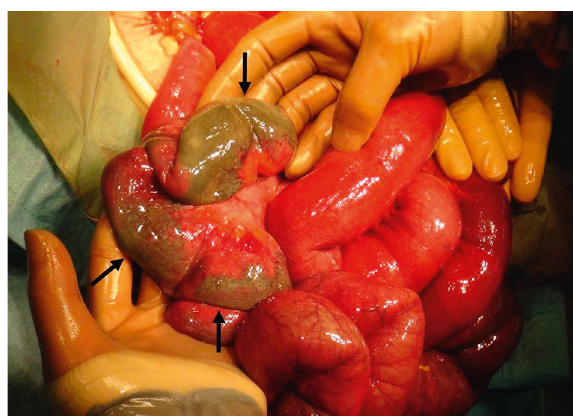
Figure 2: Intraoperative photograph. The arrows indicate the segmentally necrotic ascending colon.